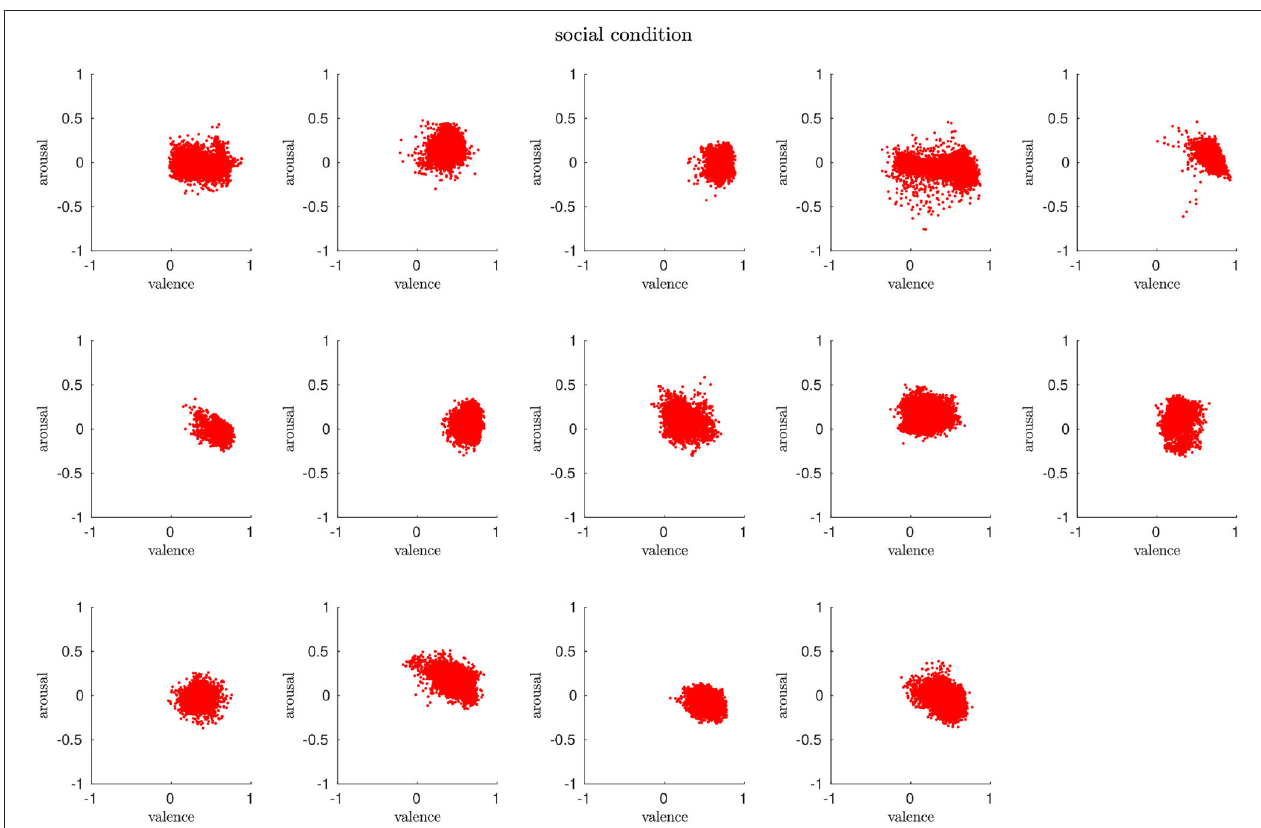
FIGURE 5 | Distribution of arousal and valence over all participants in the social condition. The affective states are mostly clustered toward positive values and are more compact compared to the non-social condition.